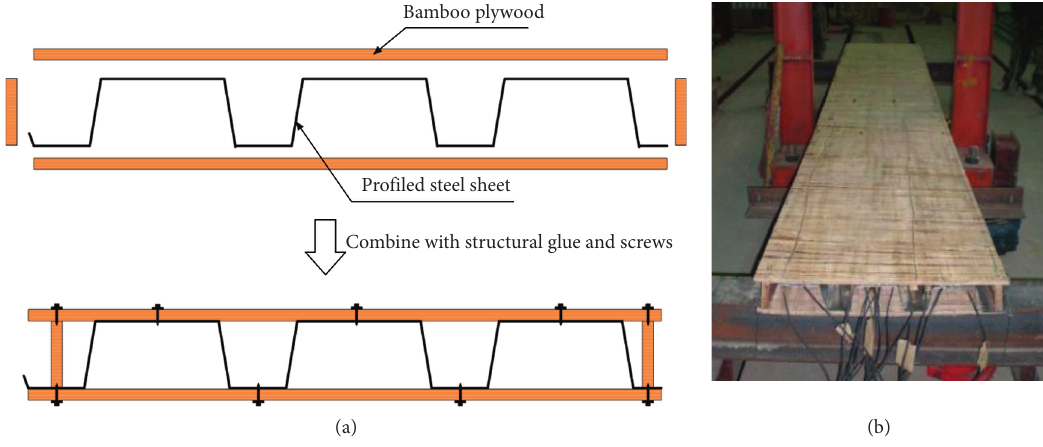
Figure 1: (a) Section form of composite slabs. (b)